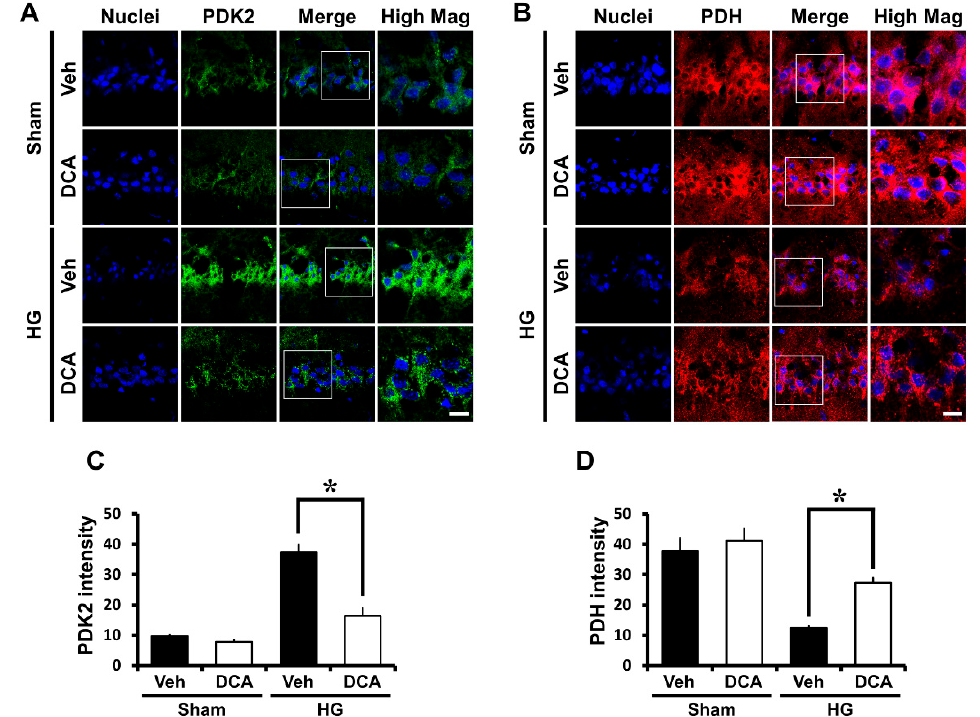
Figure 1. E ff ects of sodium dichloroacetate (DCA) on hypoglycemia-induced pyruvate dehydrogenase kinase 2 (PDK2) activation and pyruvate dehydrogenase (PDH) reduction. Fluorescent images show the e ff ect of DCA treatment on PDK2 level after hypoglycemia. ( A ) Di ff erence in PDK2 intensity between vehicle- and DCA-treated groups in the vulnerable CA1 after hypoglycemia. Scale bar = 10 µ m. ( B ) Di ff erence in PDH intensity between vehicle- and DCA-treated groups in the vulnerable CA1 after hypoglycemia. In normal state, neuronal cells maintain an adequate amount of active PDH, while hypoglycemia causes a significant reduction of active PDH. However, DCA administration recovers PDH activity. Scale bar = 10 µ m. Bar graph shows quantification of ( C ) PDK2 or ( D ) PDH intensity in CA1 region. Data are mean ± S.E.M., n = 3 from each group. * Significantly di ff erent from vehicle treated group, p < 0.05.